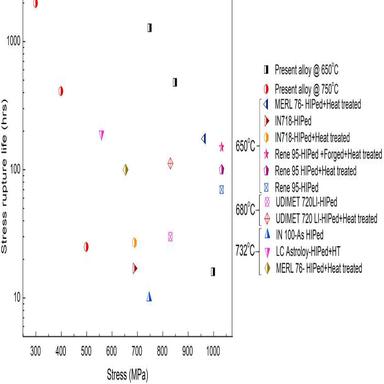
Comparative stress rupture behaviour of the studied advanced P/M superalloy with different P/M superalloys 57–.